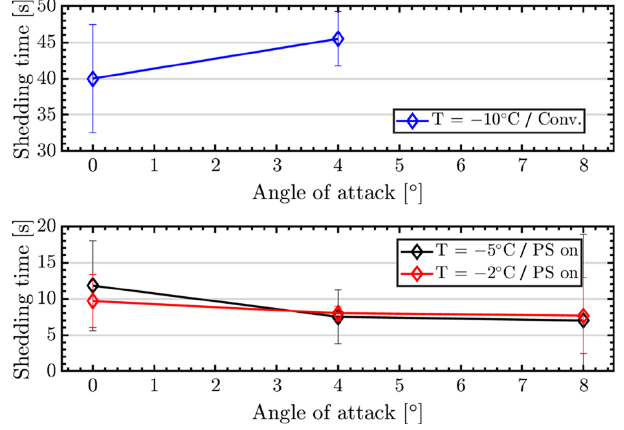
Figure 15. Comparison of shedding times between conventional (Conv.) and parting strip (PS) IPS for different angles of attack.